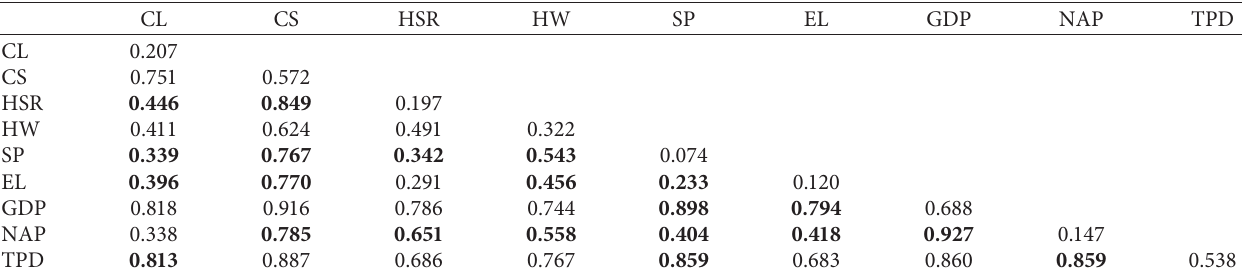
Table 5: Results of interaction detection (2000).